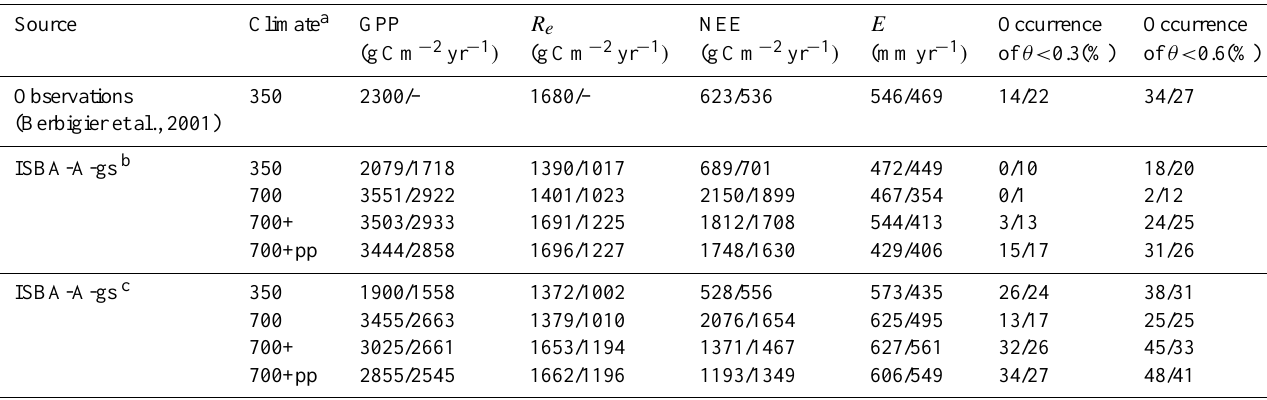
Table 5. Observed and simulated terms of the carbon and water budgets of the Le-Bray forest: Gross Primary Productivity (GPP), ecosystem respiration ( R e ) , Net Ecosystem Exchange (NEE), evapotranspiration ( E) , and occurrence of normalized extractable soil moisture ( θ ) values lower than 0.3 and 0.6. Values are presented for 1997 (from March to December) and 1998 (from January to November).